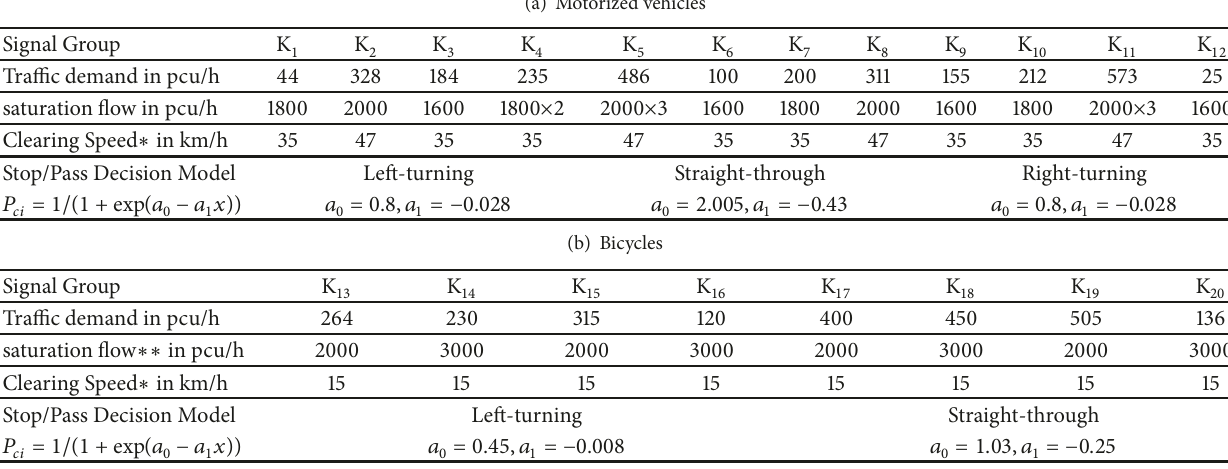
Table 1: Observed traffic volumes driver behavioural parameters as well as estimated stop/pass decision models at the study